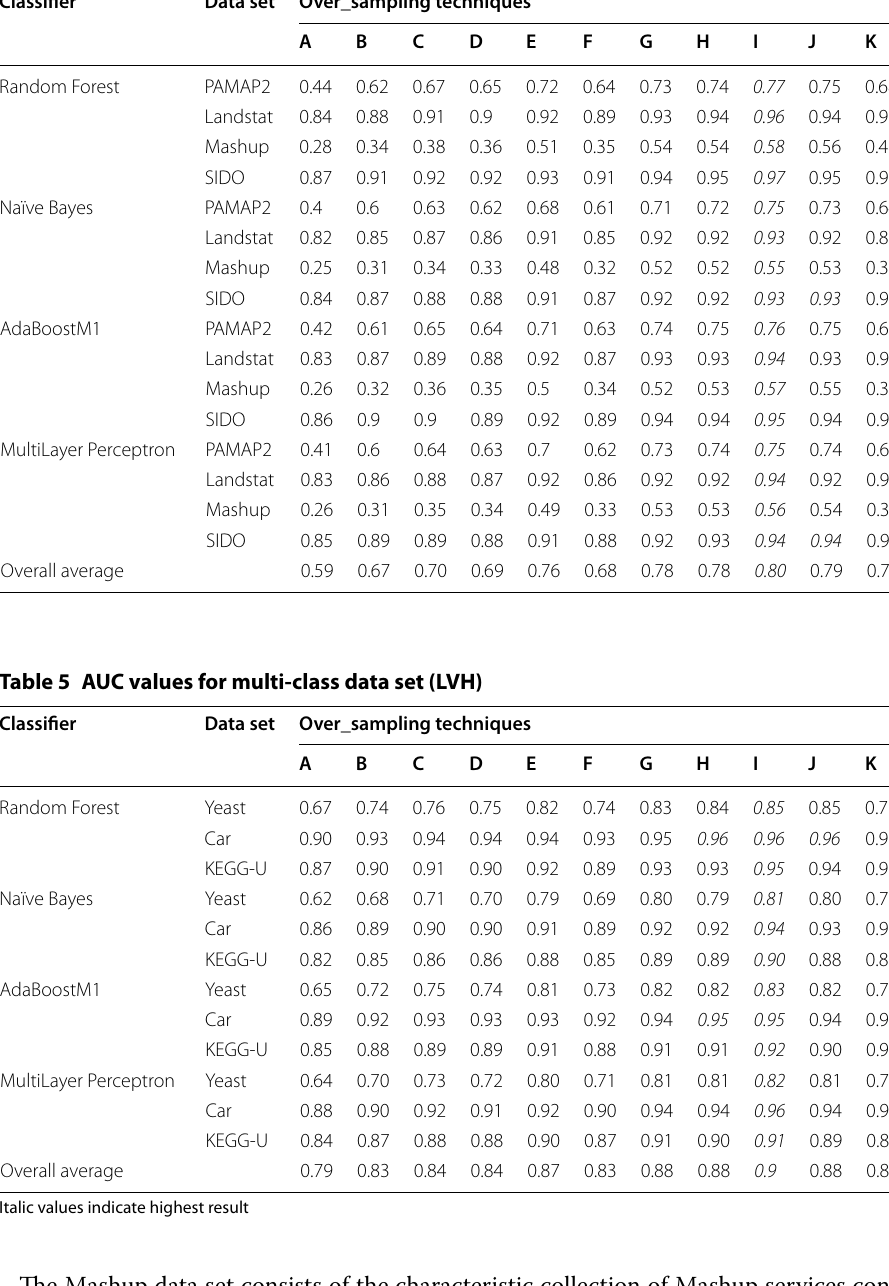
Table 4 F-measure values for multi-class data set (LVH), cross-validation Classifier